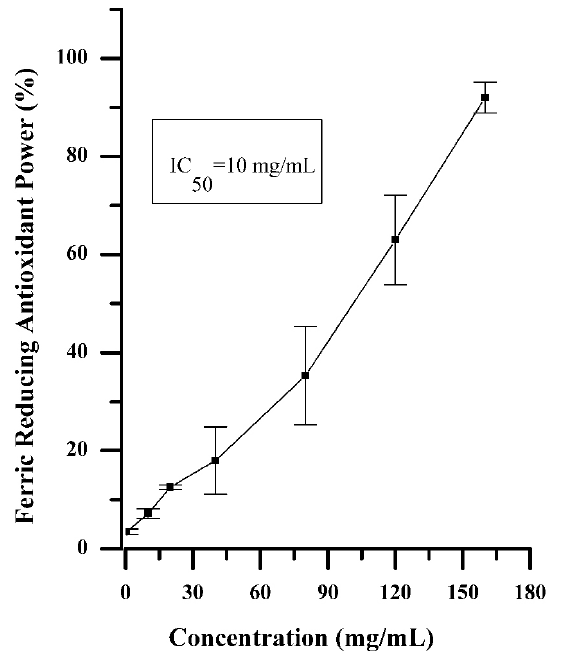
FIGURE 2 - Total iron-reducing power assay of the Passiflora edulis leaf ethanolic extract. The results represent the average ± standard deviation performed in